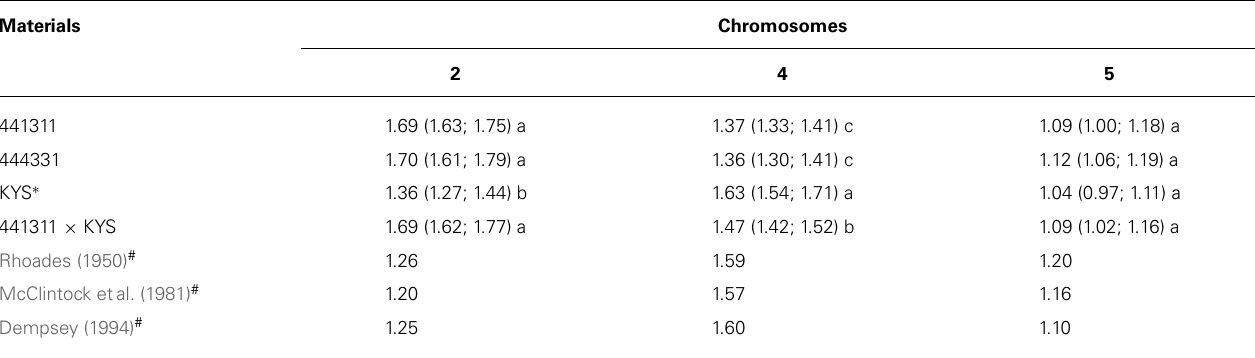
Table 3 |Arm ratios of chromosomes 2, 4, and 5 at pachytene stage from the 441311, 444331, and KYS lines and the 441311 × KYS hybrid compared with KYS data from various studies.